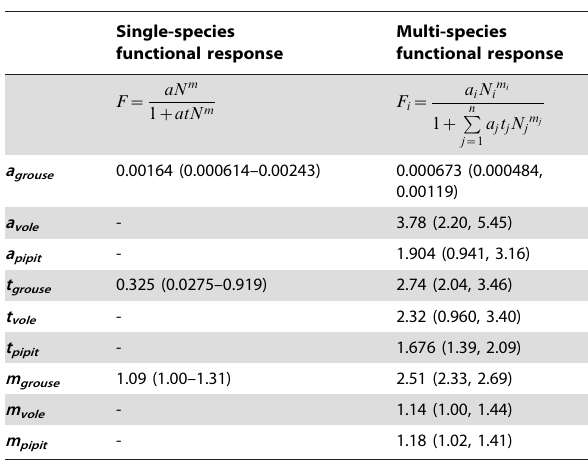
Mean parameter estimates for the single species functional response (middle column of table) and multi-species functional response (RHS column) fitted to the hen-harrier data set. The parameters are a , the encounter parameter which relates prey density to attack rate, t , the handling time (where 1/t gives the maximum consumption rate), and m , the shape parameter (values of m ... 1 indicate that switching occurs). 95% Bayesian credible intervals are shown in brackets. Subscripts indicate the prey species for which each parameter was estimated.